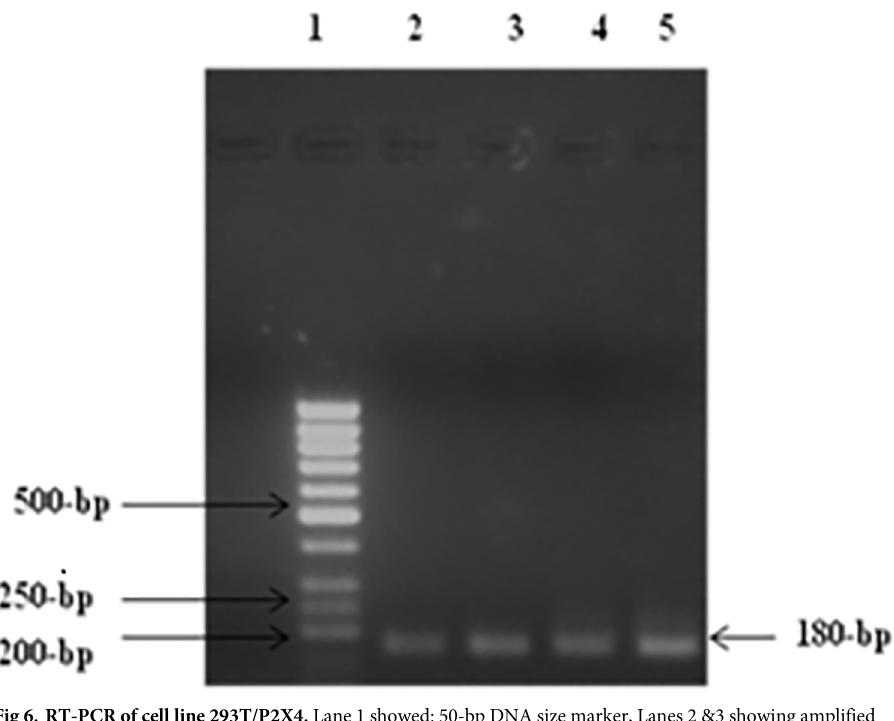
Fig 6. RT-PCR of cell line 293T/P2X4. Lane 1 showed: 50-bp DNA size marker, Lanes 2 &3 showing amplified product of transfected P2X4 (390-bp).